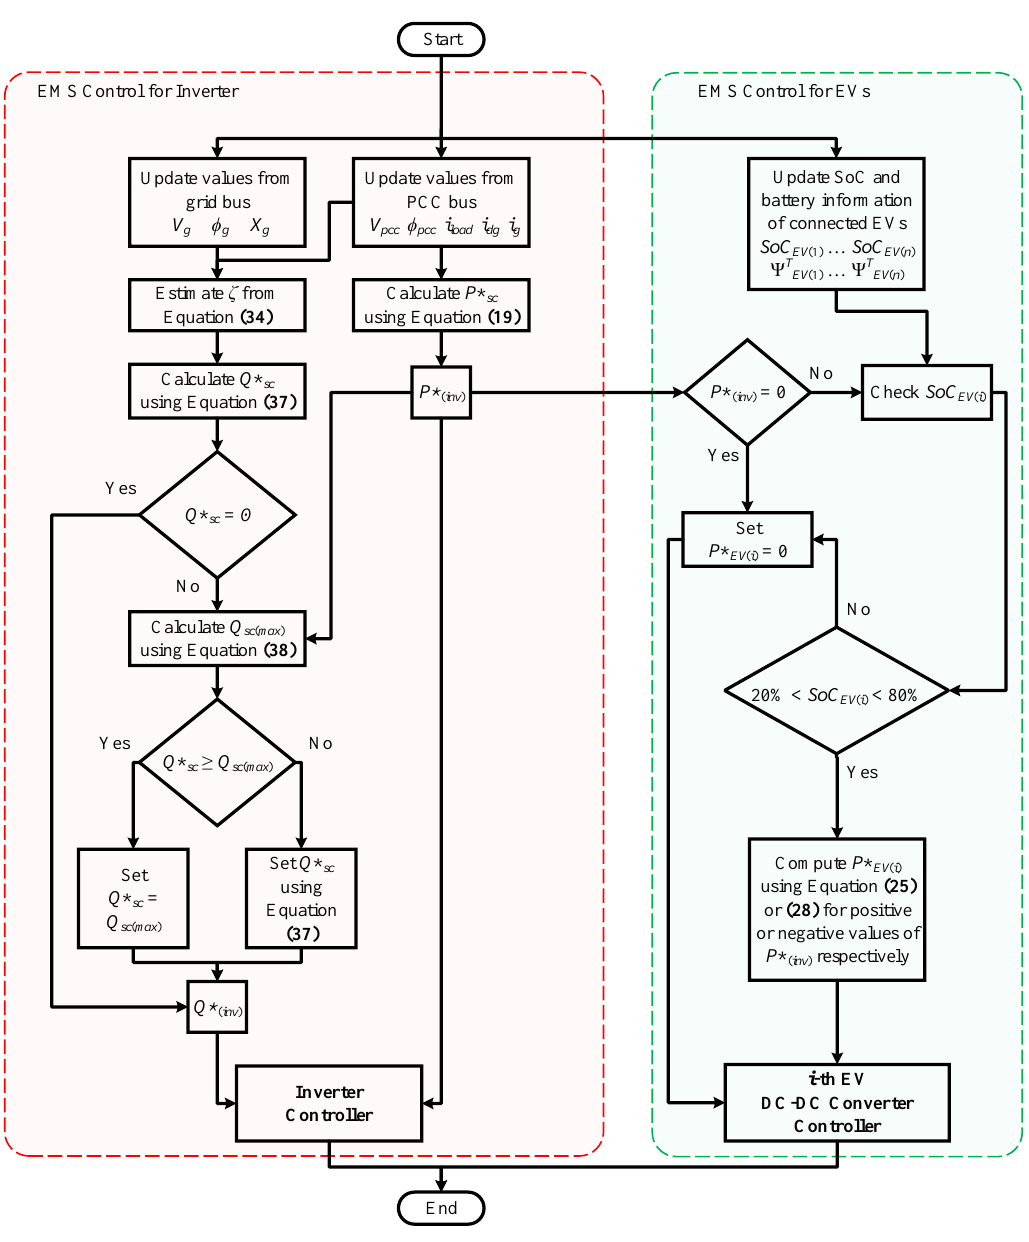
Figure 11. EMS control